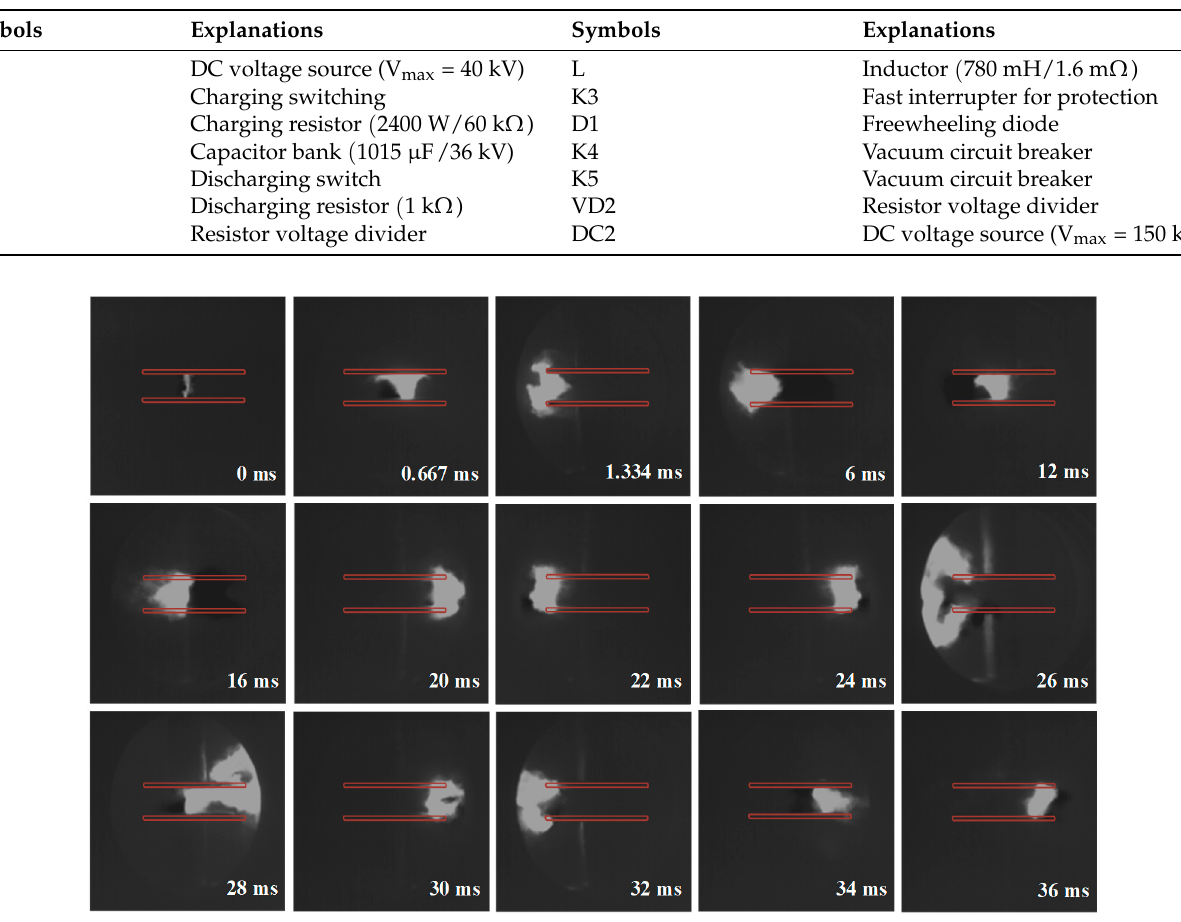
Table 4. Estimation of the averaged arc rotation velocity during the arcing process from experiment.